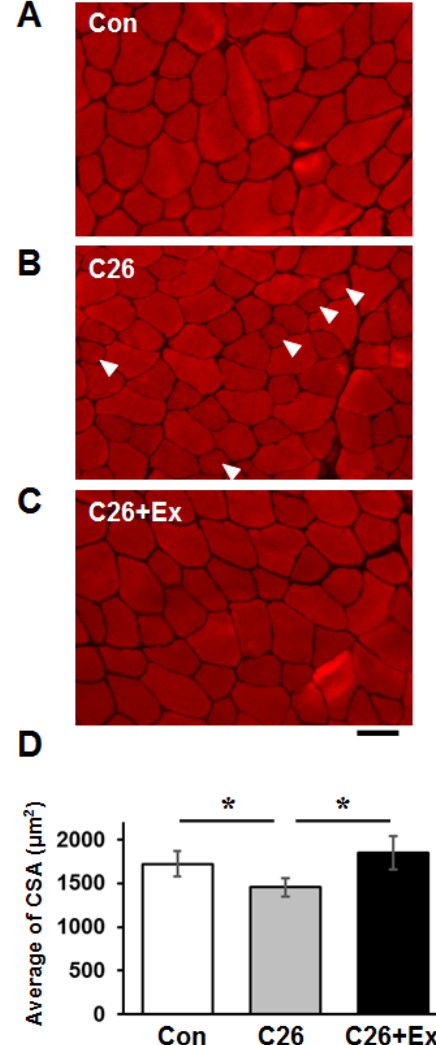
Figure 2. Aerobic exercise suppresses the atrophy of the skeletal C26-bearing mice. Cross-sections of TA muscles from ( A ) control (Con), ( B ) C26-bearing for 4 weeks (C26), and ( C ) C26-bearing and treadmill running applied for 4 weeks (C26+Ex) mice were stained with Alexa555-Phalloidin. Arrowheads indicate atrophic myofibers in B. ( D ) The average cross-section area of A-C is indicated. Scale bar: 50 µm. Statistical analysis was carried out with ANOVA followed by Tukey HSD tests. *: p < 0.05.